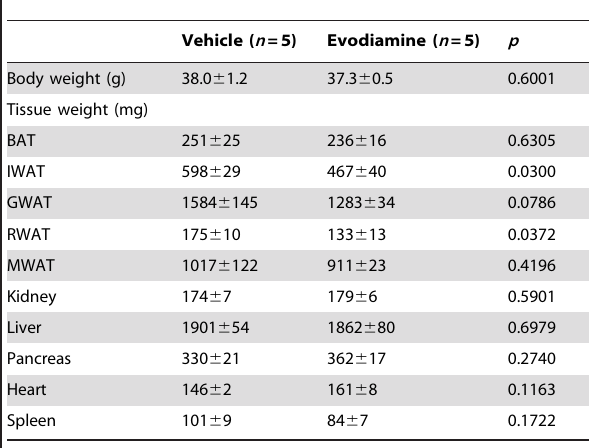
Table 1. Effect of evodiamine on tissue weight in KK-Ay